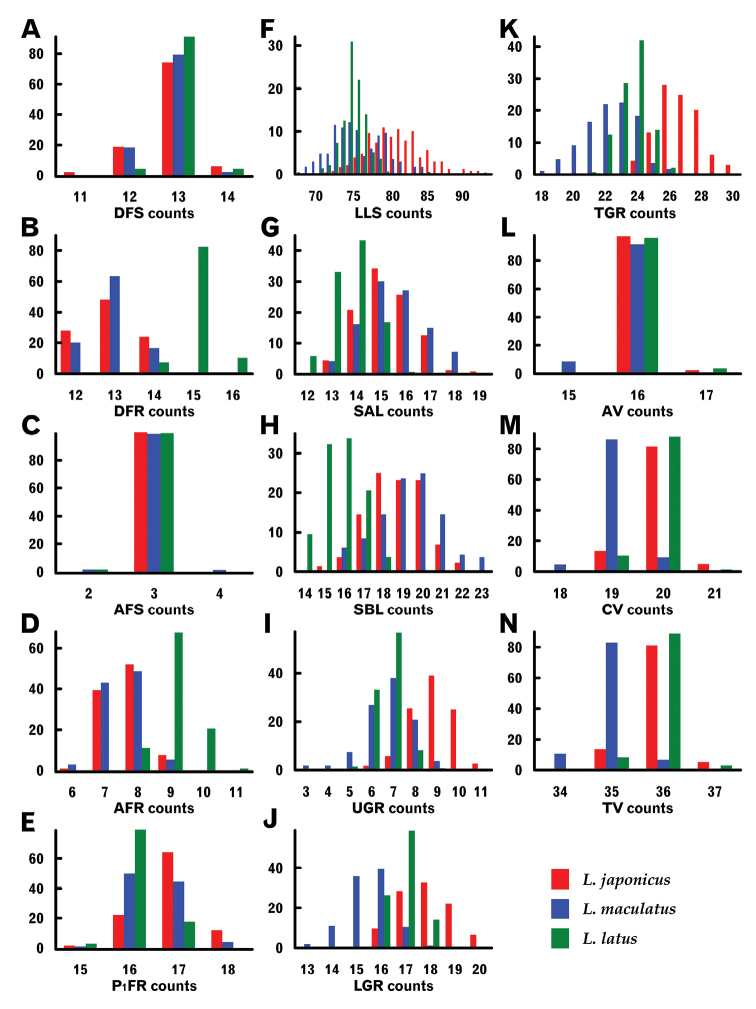
Histograms of meristic characters of three Lateolabrax species. For character abbreviations, see Figure 3 and Table 1. Vertical axes indicate frequencies (%).